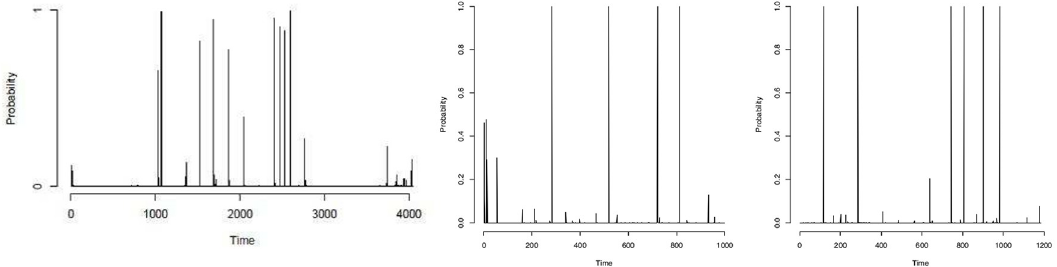
Fig 13. Comparison between the results of a random walk model [36] and our ARMA(1,1) model. (Left) change-point profiles of random walk model [36]; (centre) change-point profiles of ARMA(1,1) at time points 1 to 1000; (right) change-point profiles of ARMA(1,1) after time point 2800.